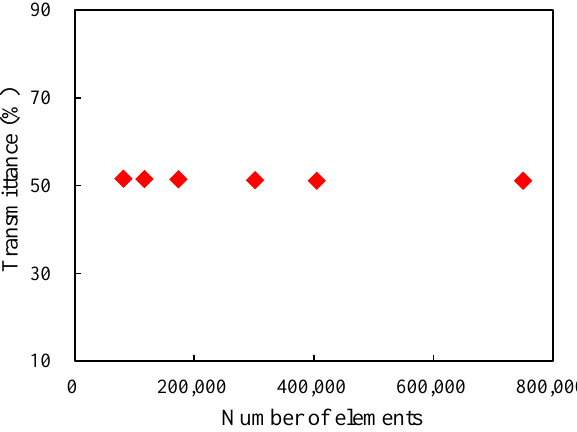
Figure 7. Evolution of the transmittance in the xy -plane with the number of elements for z = − 2.75 µ